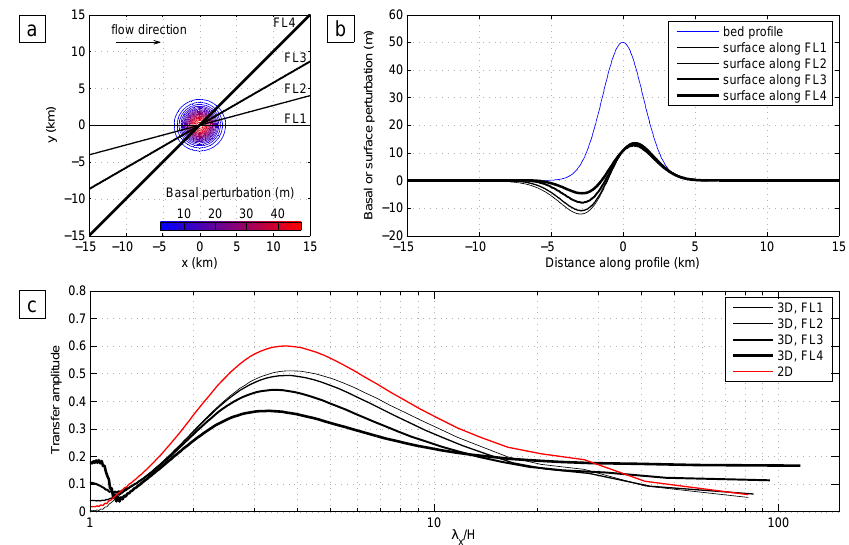
Fig. 6. (a) Gaussian-shaped bedrock undulation which was used to simulate the three-dimensional flow. Sections were taken at an angle of 0, 15, 30 and 45 degrees with respect to the flow direction and are denoted by FL1, FL2, FL3 and FL4, respectively. (b) The blue curve represents the basal perturbation which is identical along each section. Black curves represent the three-dimensional surface response along each section, showing a clear angle dependence with increased dampening of the transfer for larger angles. (c) Transfer amplitudes estimated from 1s and 1b along each section (black lines), as well as the two-dimensional result (red curve) for the same bedrock profile, uniform inclination and slip ratio. The two-dimensional flow-line limit neglects three-dimensional effects, which leads to a systematic overestimation of the transfer at wavelengths less than 20 times the mean ice